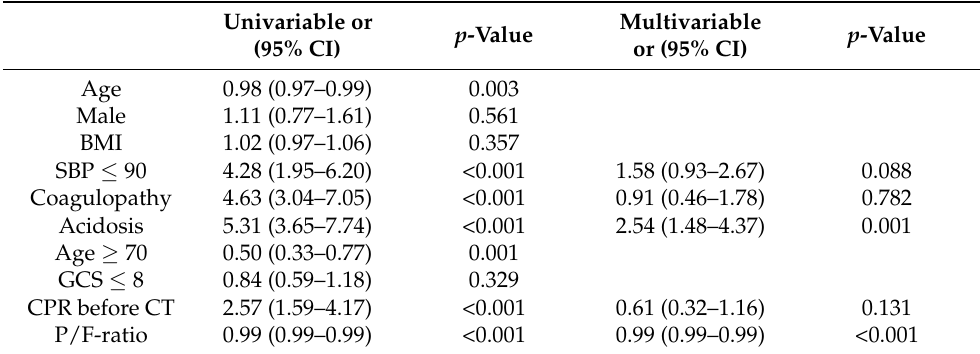
Table 5. Associations of clinical characteristics with chest tube